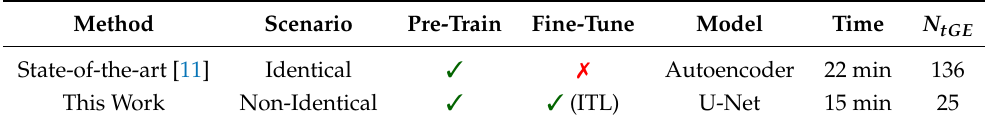
Figure 4. Comparison with different strategies for Gaussian noise removal of ASCAD dataset. Table 2. A comparison to current state-of-the-art DL-based denoising method. ITL—Inductive Transfer Learning. The summary of the training and inference time is reported (on average). N tGE represents the number of traces required to recover the secret key from the target device (on average).